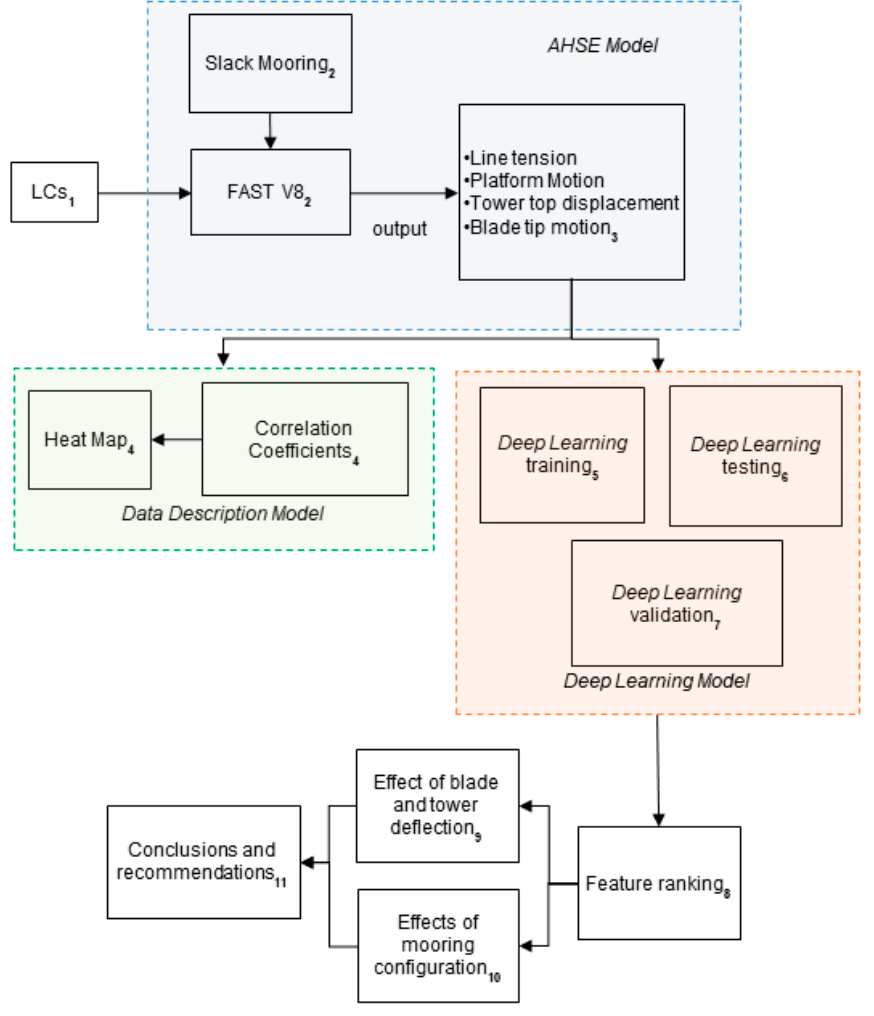
Figure 1. Configuration of methodologies.